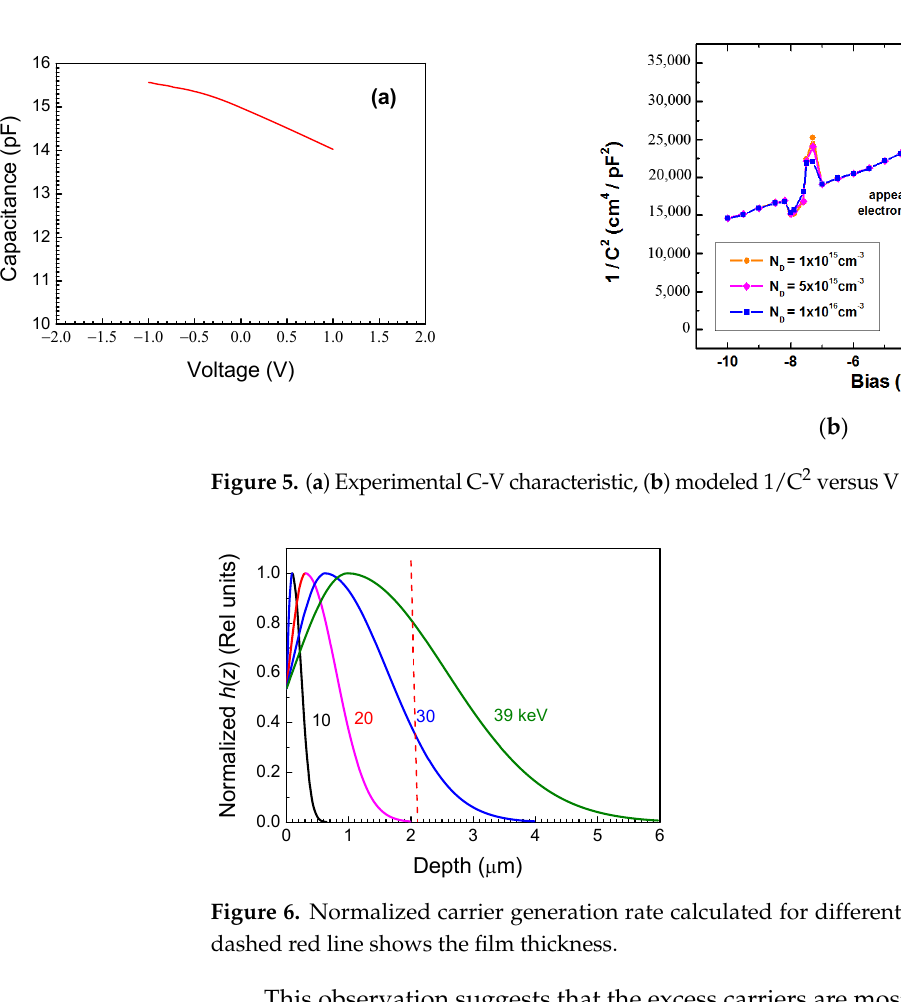
Figure 6. Normalized carrier generation rate calculated for different probing beam energies. The dashed red line shows the film thickness.